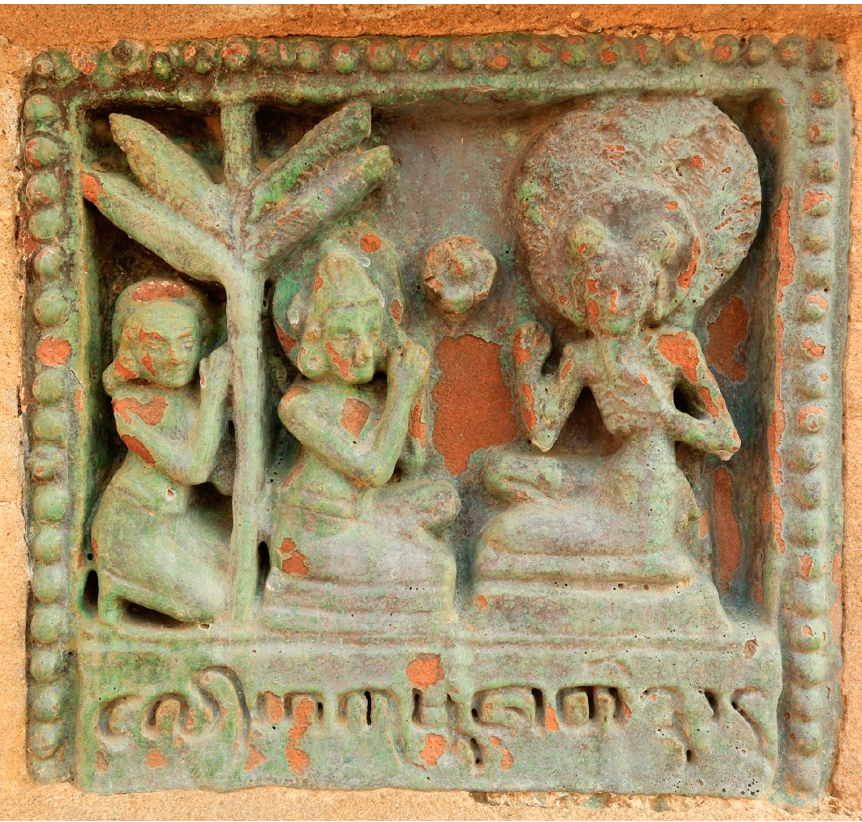
Figure 42. Pagan, Ananda, 11th century. Lohakhumbi J ā taka, 314.